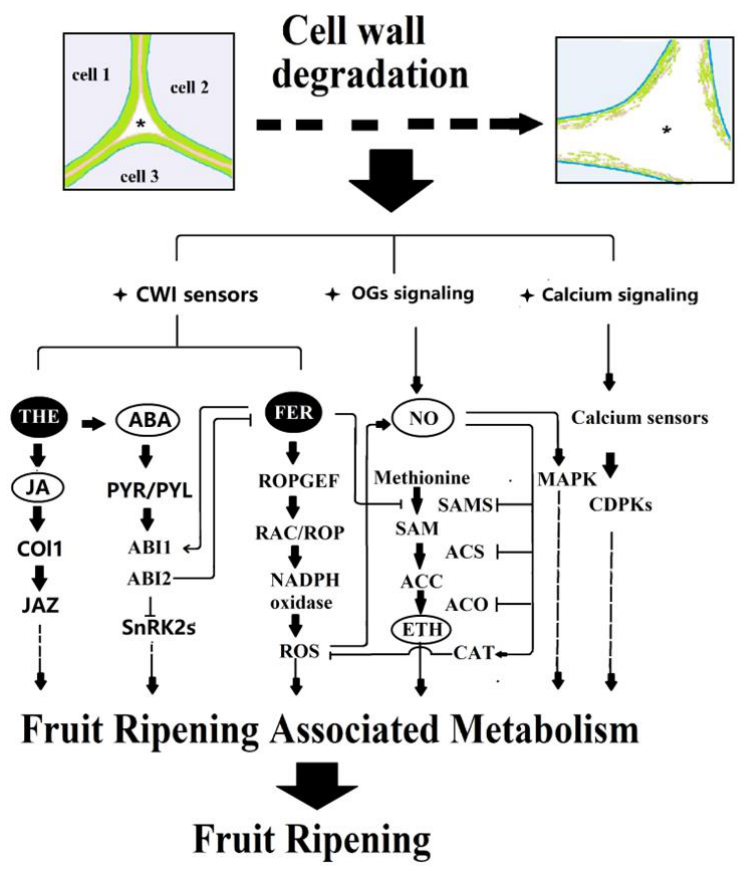
Figure 1. Proposed diagram showing CWI signaling in fruit ripening. Fruit growth and development are accompanied by cell wall degradation, which starts from cell separation resulting from pectin degradation. The cell wall degradation triggers several signaling systems, including RLK-associated signaling, OGs signaling and Ca 2+ signaling, NO signaling, etc. Among the RLK-associated signals, CrRLK1Ls, particularly FER, and THE, have been established to play pivotal roles in both hormone signal production and transduction. OGs and Ca 2+ signaling may potentially play important roles in the initiation of fruit ripening via or not via modulation of hormone signaling. NO potentially acts as a signal downstream of OGs signals and is proposed to be linked with multiple signaling pathways, among which the ethylene biosynthesis pathway has been well characterized. *, apoplastic space of tricells, showing cell separation and wall degradation.The wall model is based on a study by Zhang et al. [6] RLK, Receptor Like Protein kinase; OGs, oligosaccharides; FER, Feronia; THE, Theseus. SnRK2, sucrose nonfermenting 1-related protein kinase 2, PYR/PYL, ABA receptor; ABI1/2, protein phosphatase 2C; RopGEF, guanine nucleotide exchange factors; RAC/ROP, small GTPase; ROS,